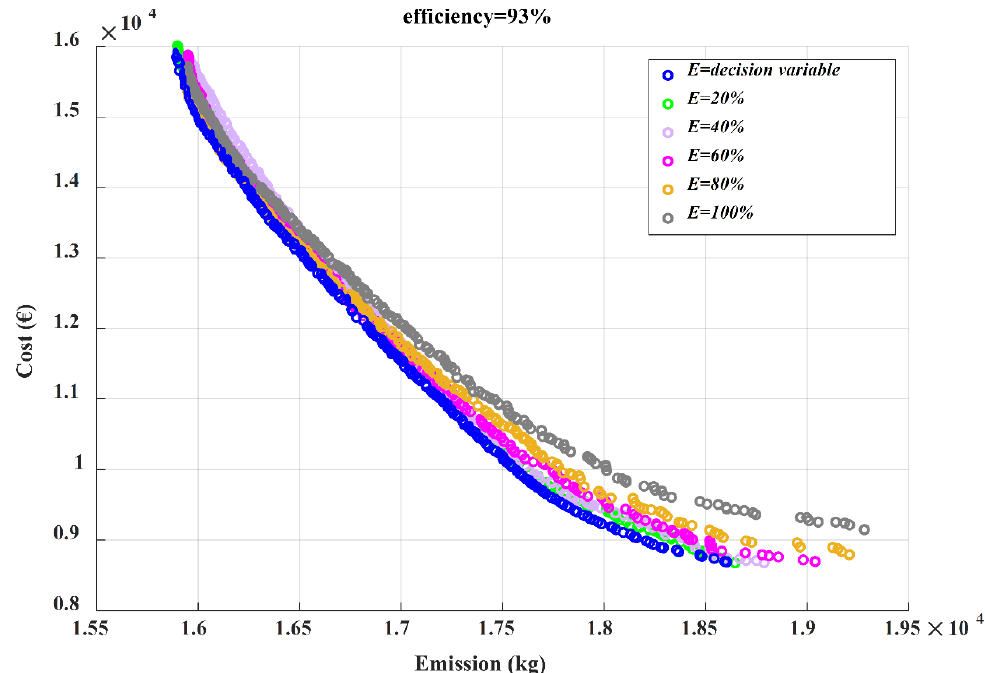
Figure 11. Comparison of Pareto optimal fronts for different E values (93% efficiency).